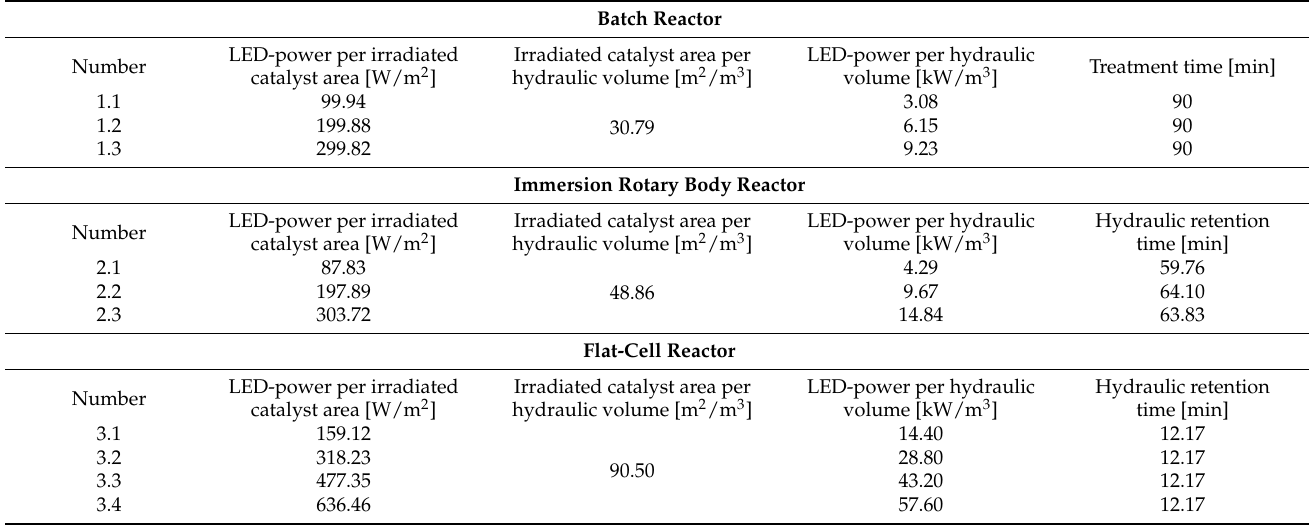
Table 1. Experimental reactor operation and geometric parameters. Batch